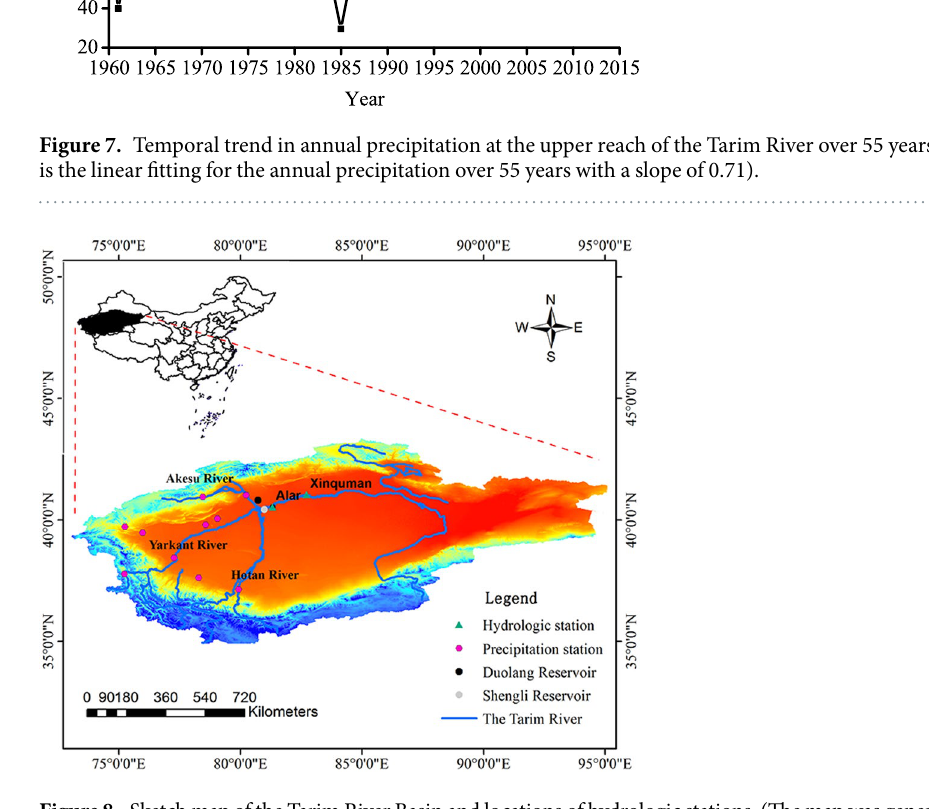
Figure 8. Sketch map of the Tarim River Basin and locations of hydrologic stations. (The map was generated with data available from the Chinese Geospatial Data Cloud using ESRI’s ArcGIS (version 10.1;